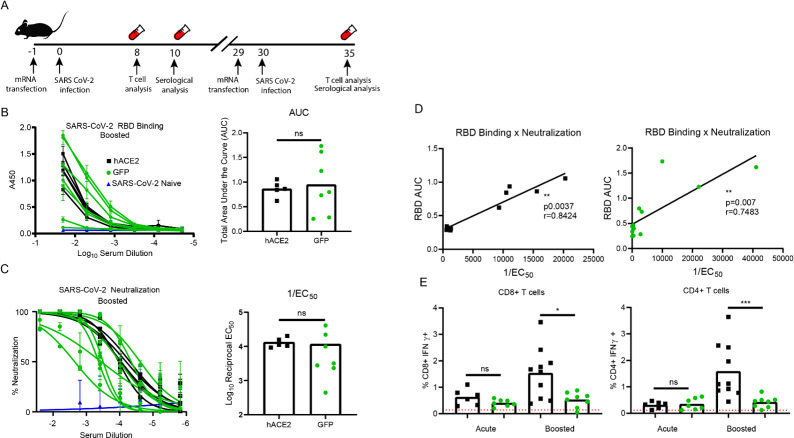
In vivo transfection of hACE2 mRNA yields enhanced CD4+ and CD8+ T cell responses.(A) Experimental design. 8-week-old Ifnar1-/- mice were transfected with 10 μg of GFP or hACE2 mRNA. 24 hours post transfection, mice were infected with SARS-CoV-2. At days 8 and 10 post infection, blood was collected for acute phase T cell stimulation assays and serology recpectively. At days 29 post initial infection, the mice were again transfected with 10 μg of GFP or hACE2 mRNA and infected 24 hours later. 5 days post boost, blood and serum was collected for memory recall T cell stimulation assays and serological analysis. (B) Spike RBD ELISA. Serially diluted serum from mice five days post boost was added to a recombinant SARS-CoV-2 spike RBD protein coated plate to determine RBD binding potential by absorbance at 450nm. The results of the dilution series was used to calculate the area under the curve calculation. (C) Neutralization potential of polyclonal sera. As above serum from boosted mice was serially diluted with ~100 focus forming units of SARS-CoV-2. Neutralization was determined by enumerating a reduction in infectious particles with increased serum concentration and determining the EC50. (D) Correlation between RBD binding and SARS-CoV-2 neutralization for both the hACE2 and GFP transfected SARS-CoV-2 infected Ifnar1-/- mice. Correlative analysis between RBD ELISA AUC values and 1/EC50 values was performed using linear regression analysis and a two-tailed Pearson analysis p<0.0037, r = 0.8424 and p<0.007, r = 0.7483 for the hACE2 and GFP transfected mice respectively. (E) Global T cell responses during SARS-CoV-2 infection. Eight days post infection and five days post boost, collected blood lymphocytes were stimulated with anti-CD3 nd stained with anti CD19, CD4, CD8, IFNγ and TNFα. The frequency of responding CD8+ and CD4+ T cells was demonstrated by quantifying the frequency of CD8+ or CD4+ T cells producing IFNγ. The gating strategy is shown in S3 Fig. Statistical significance was determined by Mann-Whitney test (p = 0.025 and 0.0009 for CD8+ and CD4+ boosted T cell responses, respectively).